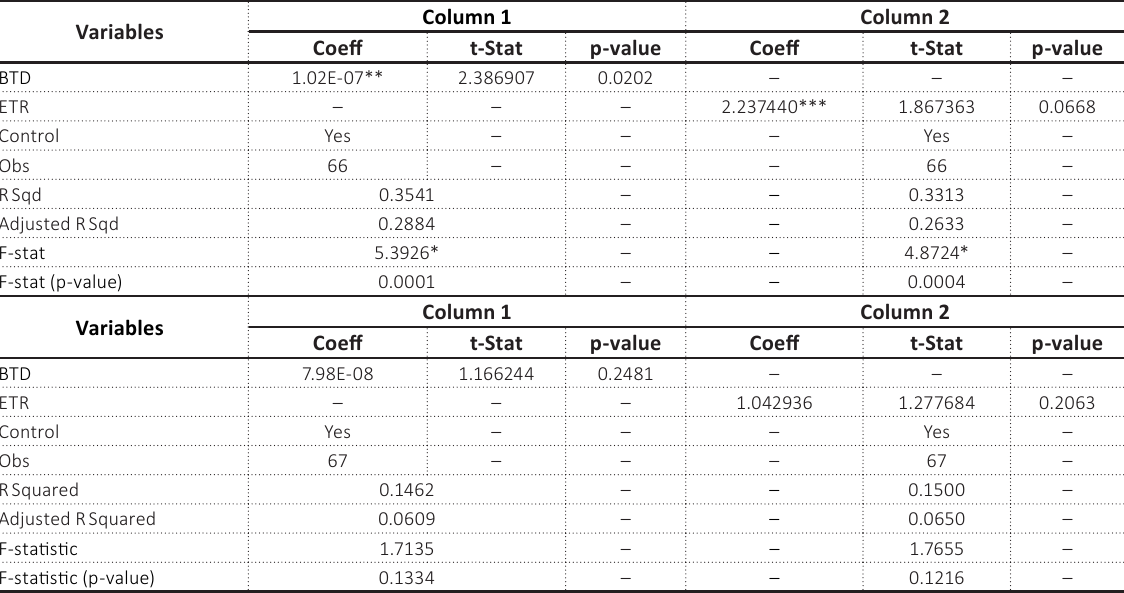
Table 5. Pooled OLS estimation (Sound/weak